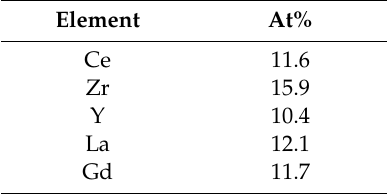
Table 1. Chemical analysis by EDS of area highlighted in Figure 6